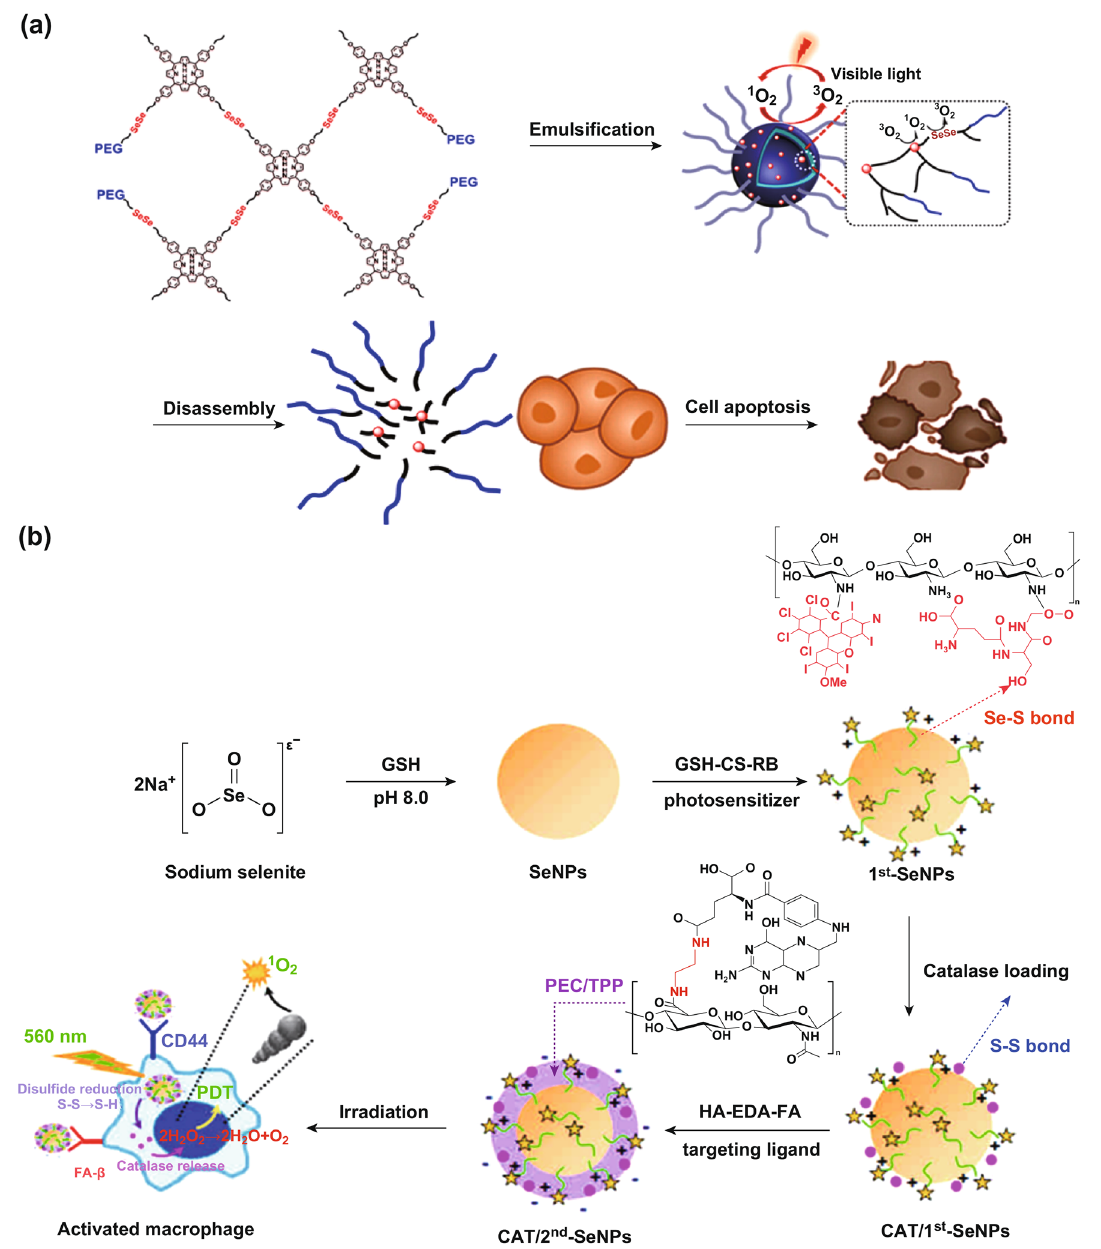
Fig. 13 a Schematic illustration of the formation of the PSe-Por micelles. After light irradiation, the oxidization product has anticancer activity. Adapted with permission from Ref. [69]. Copyright 2017 American Chemical Society. b Schematic diagrams for the preparation of catalase- loaded SeNPs and photodynamic treatment. Adapted with permission from Ref. [70]. Copyright 2017 American Chemical